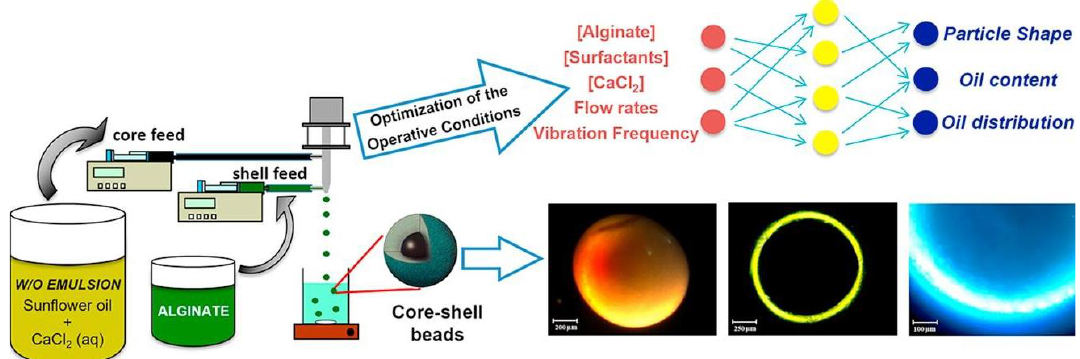
Figure 17. Schematic illustration of the method employed for the production of core-shell microparticles by inverse gelation optimized with artificial intelligent tools. Reprinted from [200] with permission from Elsevier. Copyright